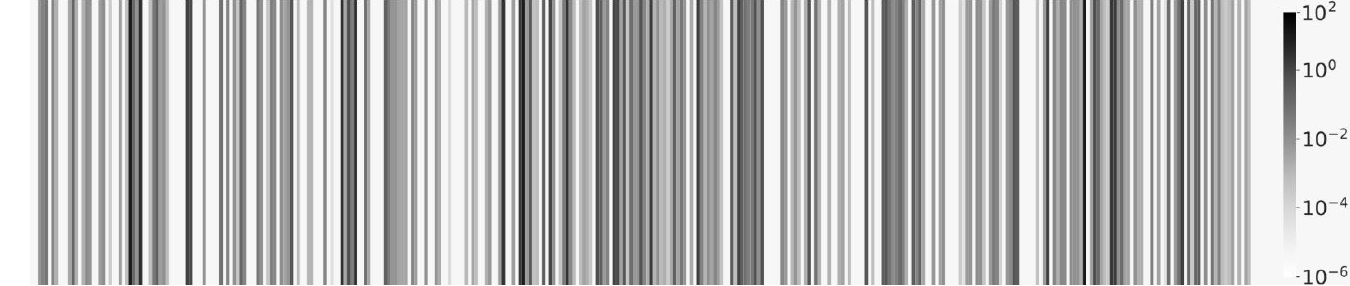
Figure 1. The relative counts of the genus levels of a T2D sample represented by a 1D heatmap. The legend shows the logarithmic scaling of abundances of the bacteria as gray-scales.